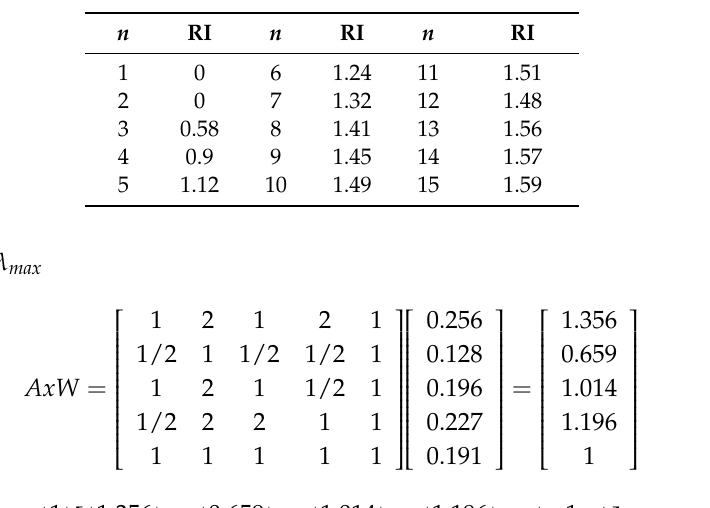
Table 7. Random inconsistency indices RI (source